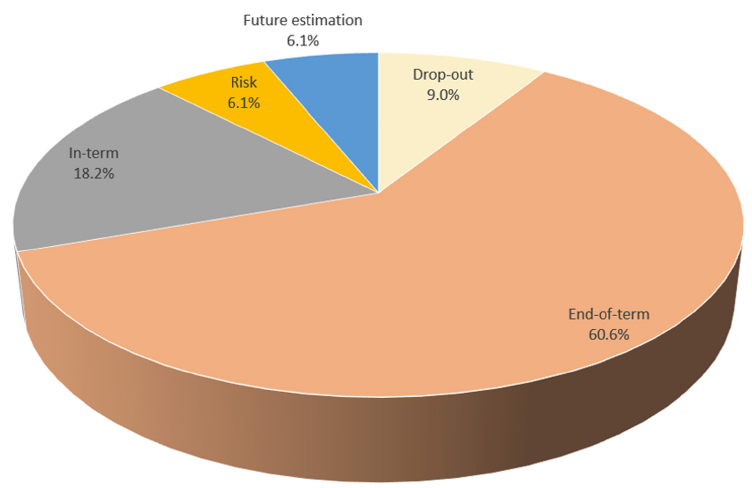
Figure 4. The aims of student performance prediction studies in percentages for educational